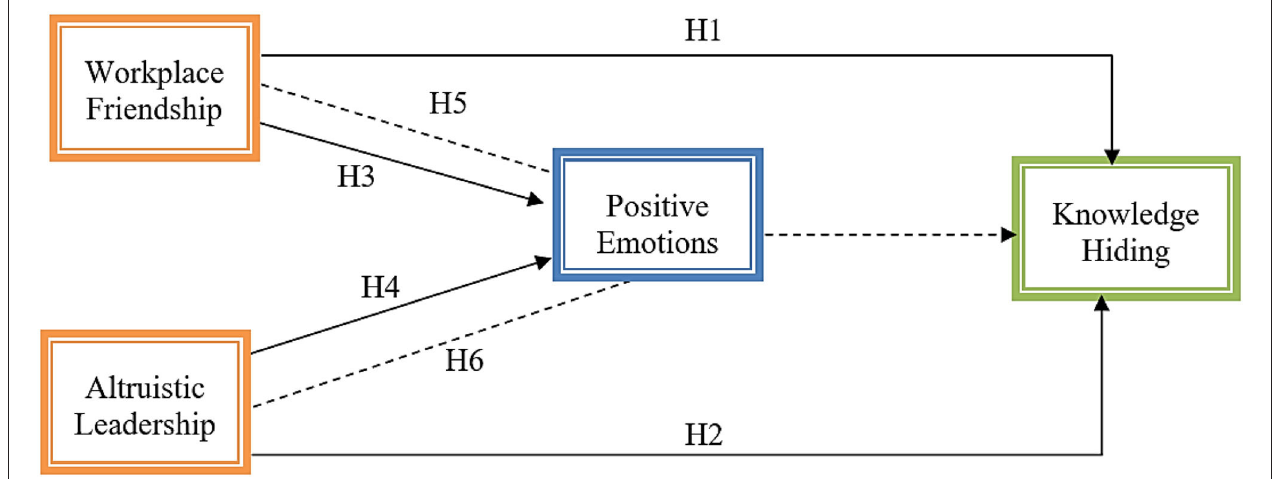
FIGURE 1 | Research